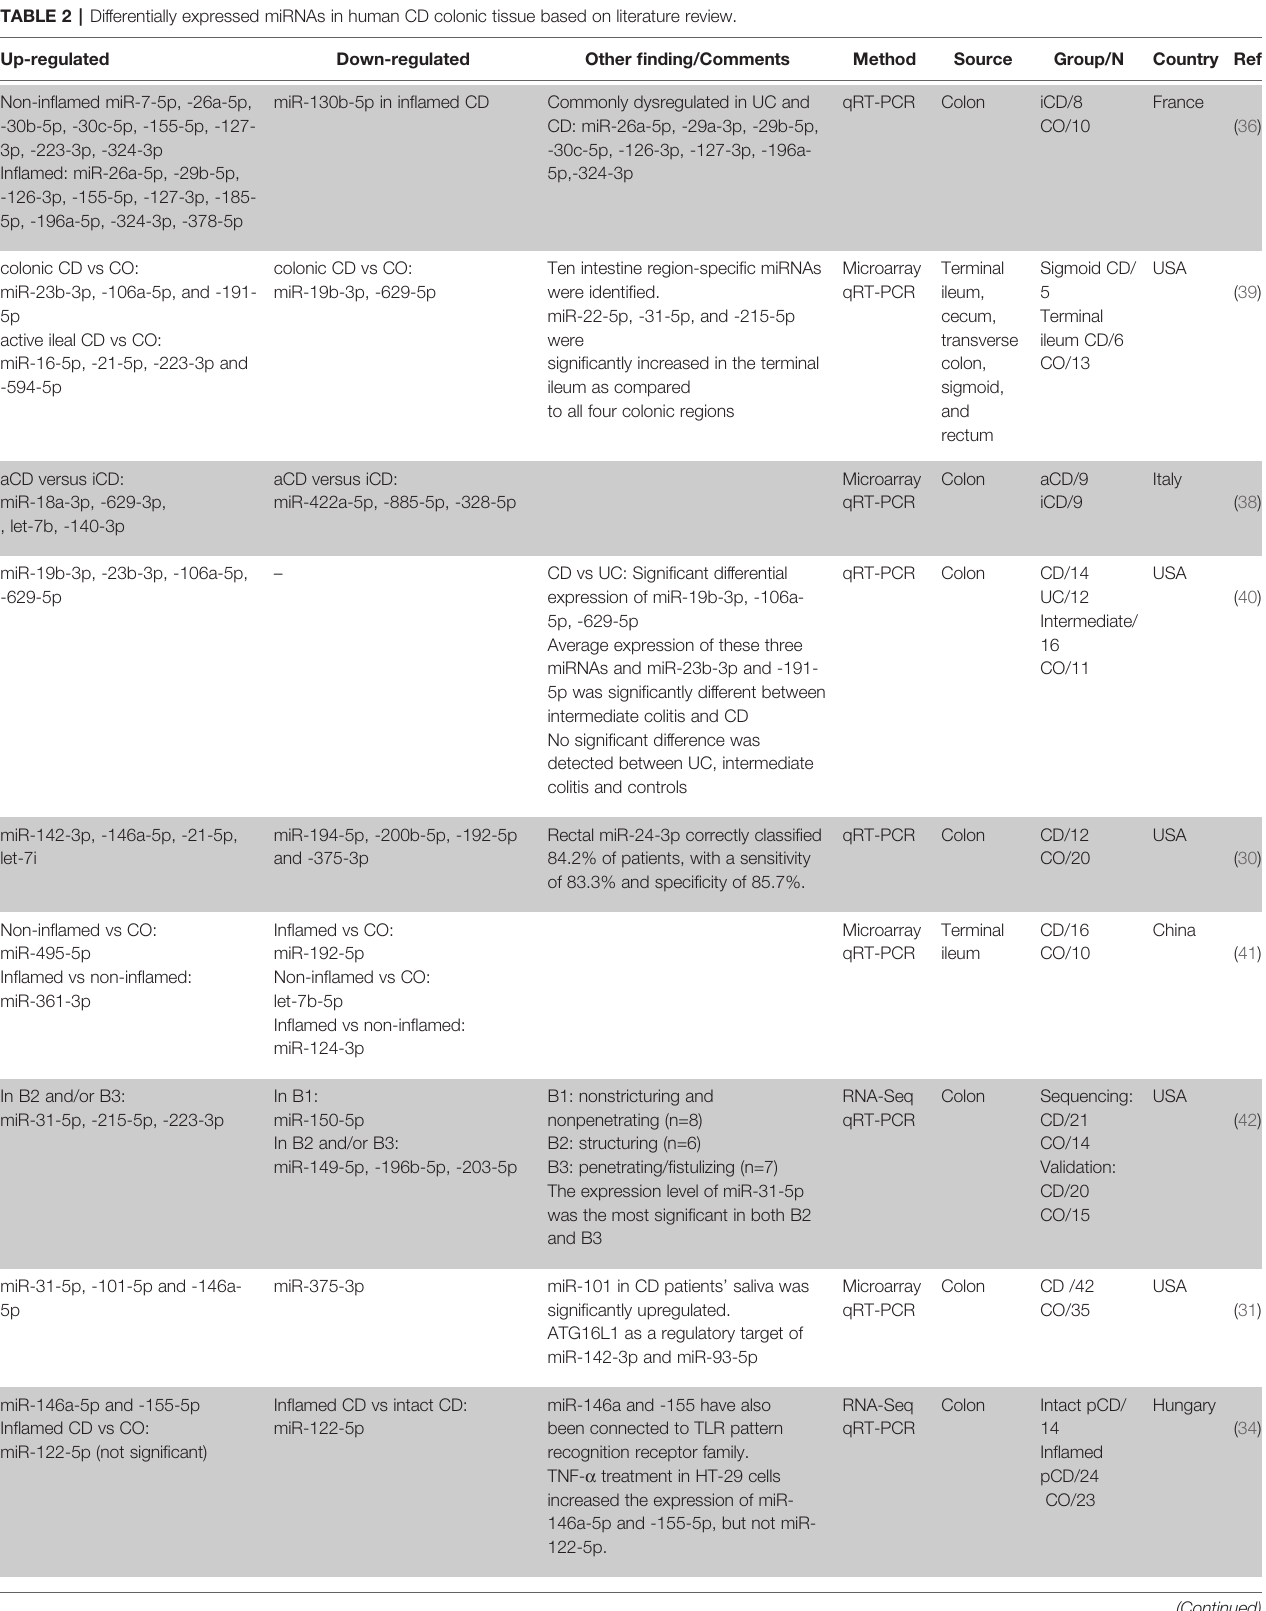
TABLE 2 | Differentially expressed miRNAs in human CD colonic tissue based on literature review.